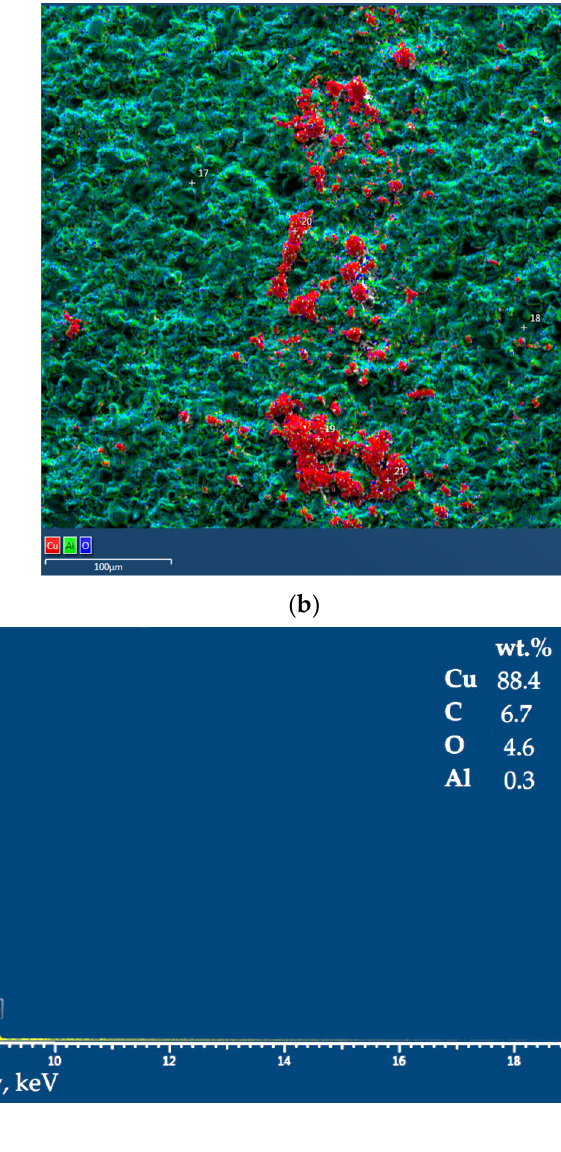
Figure 8. SEM-analyses of the machined kerf in the Al 2 O 3 sample: ( a ) image in secondary electrons, 5.00 k × ; ( b ) chemical mapping, 1.00 k × ; ( c ) energy dispersive spectroscopy of the deposed